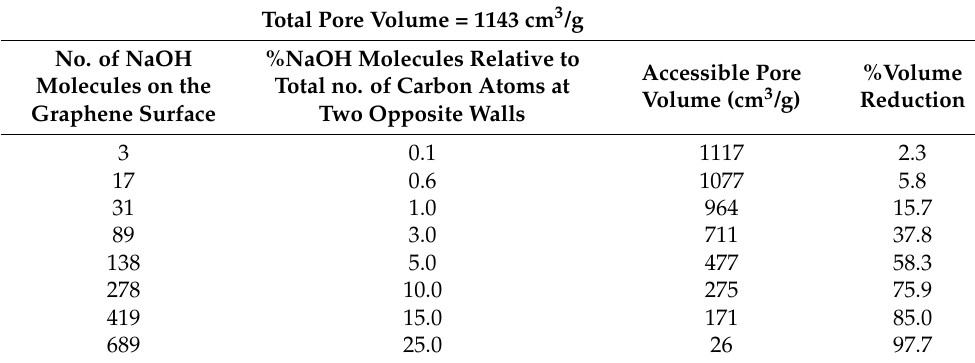
Figure 4. Snapshots from GCMC simulation showing the adsorption of nitrogen molecules onto the randomly distributed NaOH molecules on the graphene surface of the slit pore model of activated carbon for various increasing adsorption pressures (green spheres, red spheres, and gray spheres represent Na atoms, OH groups, and nitrogen molecules, respectively). Table 4. Accessible pore volume for CO 2 adsorption as a function of NaOH loading in a pore of 1.5 nm in width, computed from GCMC